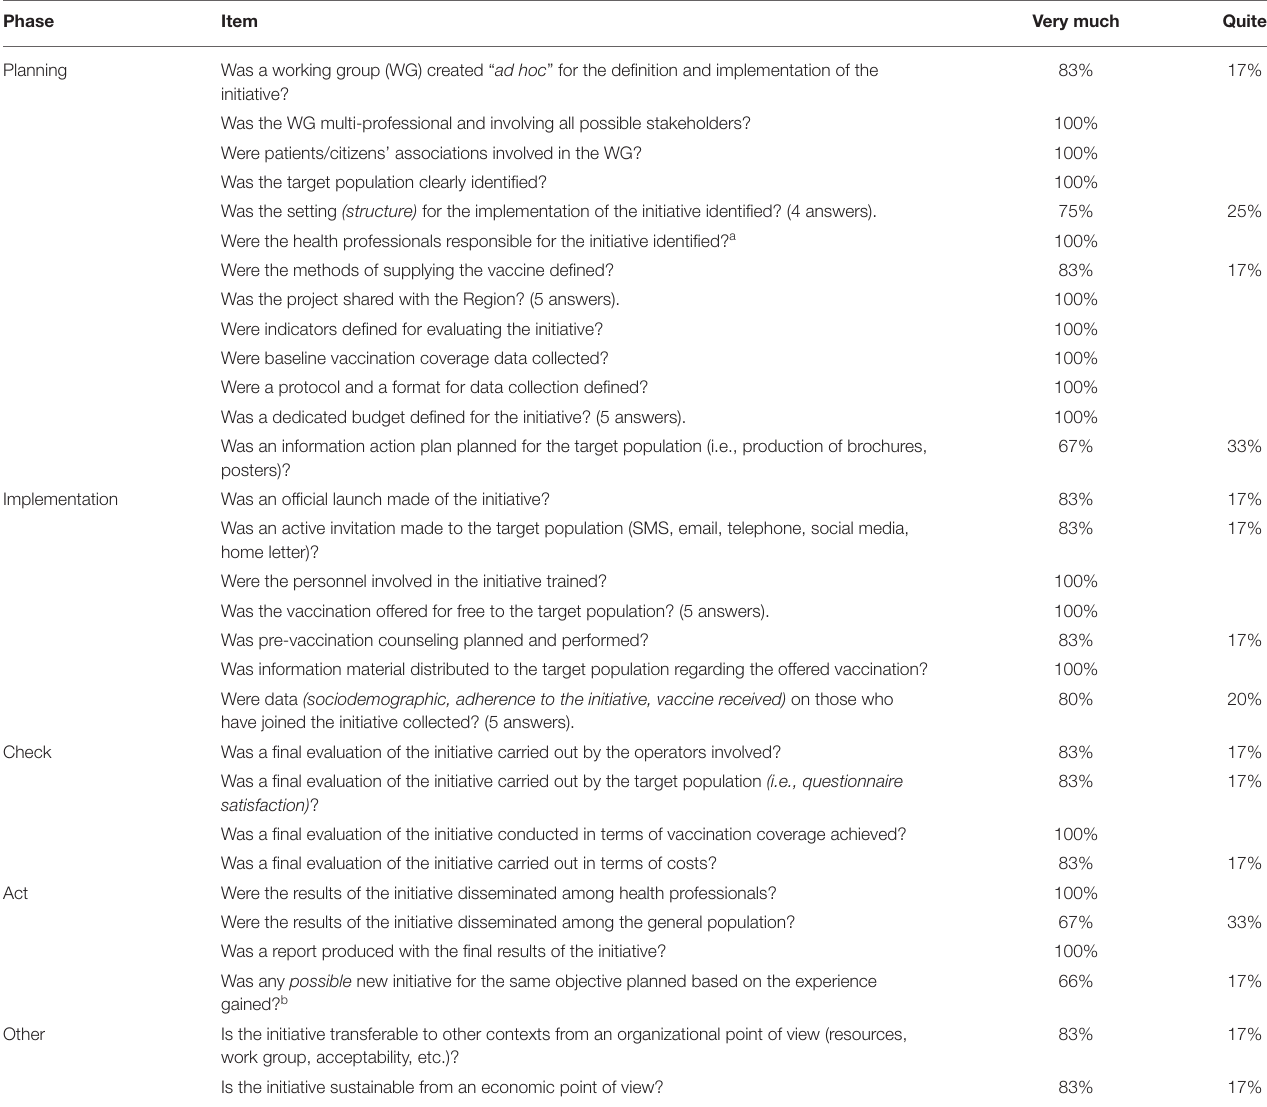
TABLE 1 | Items of the first version of the tool and results of the first round of